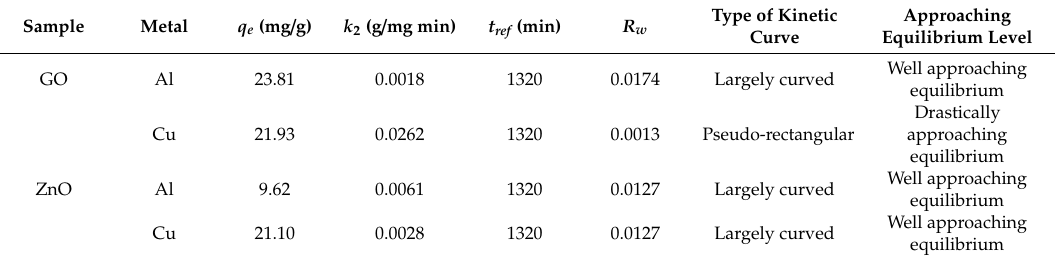
Table 3. The approaching equilibrium factor (Rw) in the pseudo-second-order kinetic